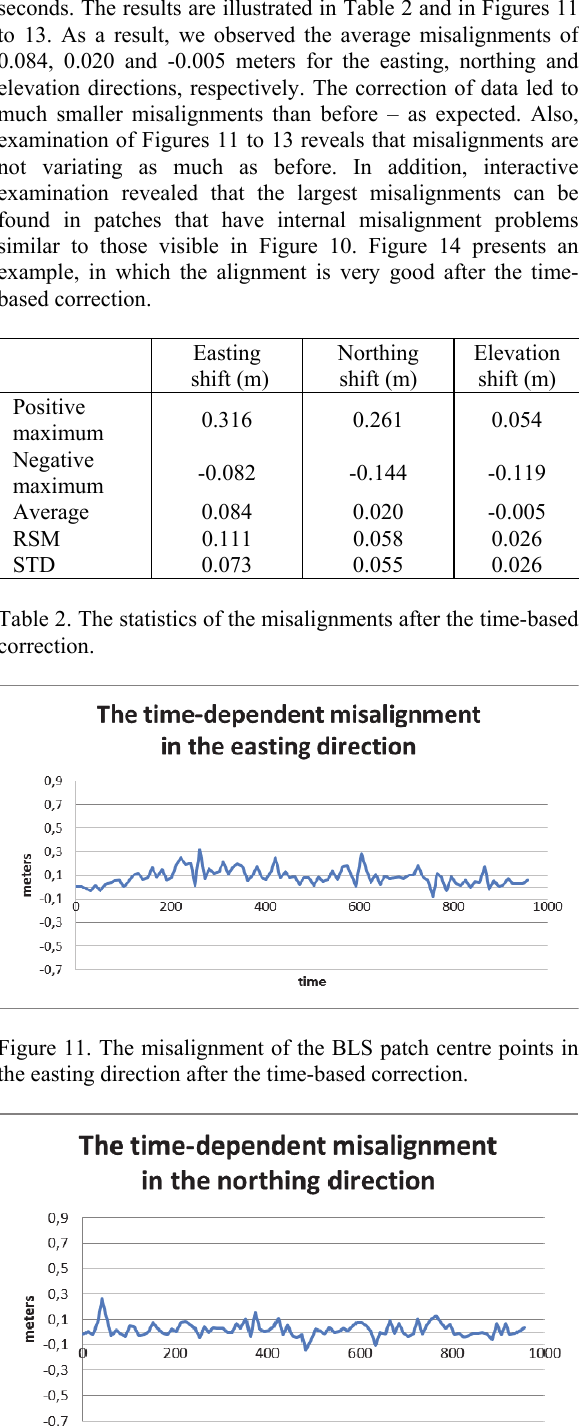
Figure 10. The sideview (left image) and the topview (right image) of a tree trunk from the time-based corrected BLS point cloud. All visualized data belongs to one patch. As an example, the time difference between blue and green color is circa 3 seconds and between blue and red circa 6 seconds.